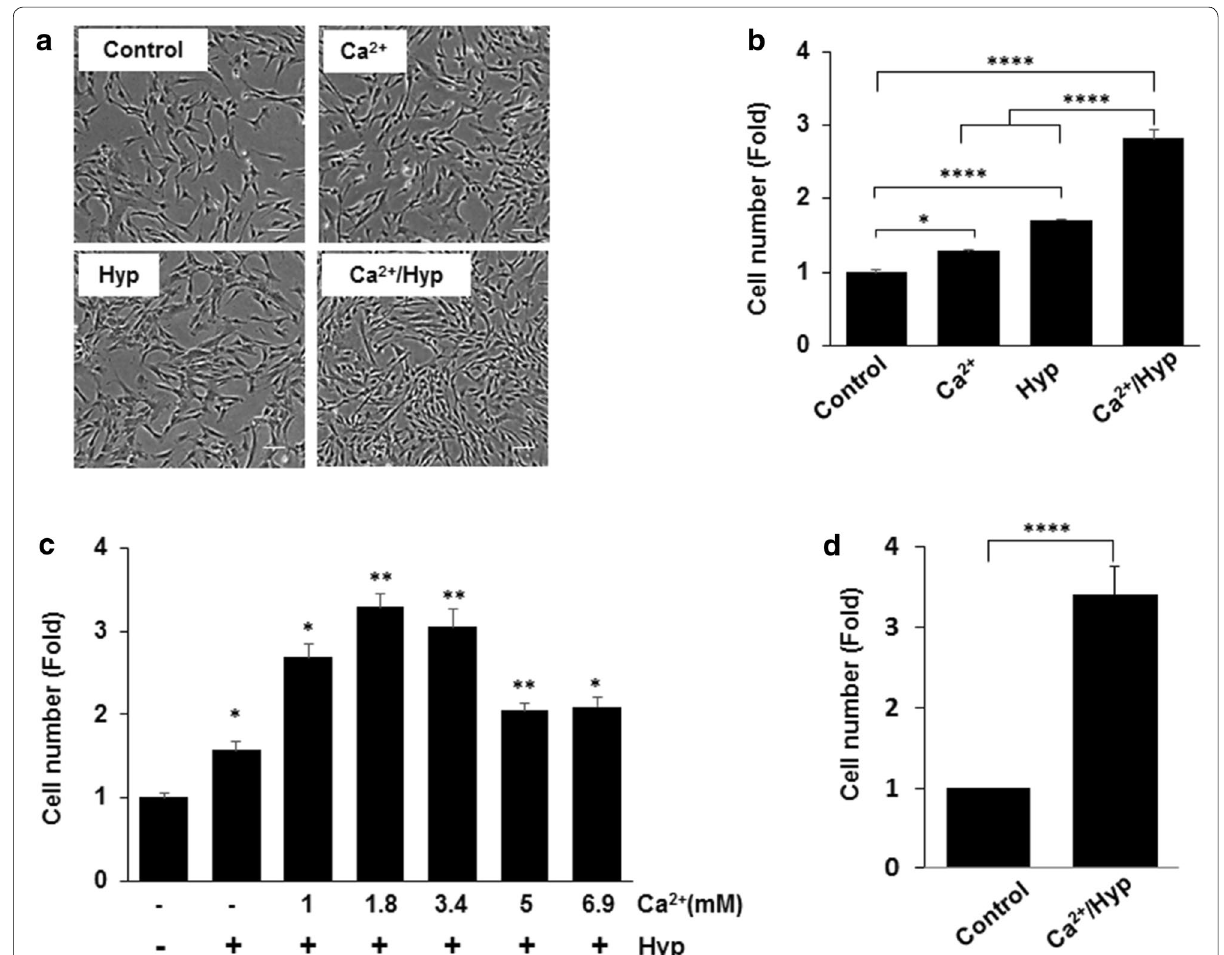
Fig. 1 Effects of Ca 2 + /hypoxia on the proliferation capacity of hUCB‑MSCs. a , b hUCB‑MSCs were treated with Ca 2 + , hypoxia, or Ca 2 + /hypoxia for 5 days. The morphology and growth curve of cultured hUCB‑MSCs were analyzed. Ca 2 + /Hyp: Ca 2 + plus hypoxia; Hyp: hypoxia. c hUCB‑MSCs were treated with the indicated concentrations of Ca 2 + under hypoxic conditions (3% oxygen) for 5 days. d Six batches of hUCB‑MSCs were tested for proliferation in the Ca 2 + /hypoxia condition. The initial cell concentration of hUCB‑MSCs was 5 10 3 cells/cm 2 . Cell proliferation was measured by × cell counting assays. Data represent the mean SD, n 3; * P < 0.05, ** P < 0.01, *** P < 0.001, **** P < 0.0001. Scale bar 100 μm (magnification: ± = = 100 ×